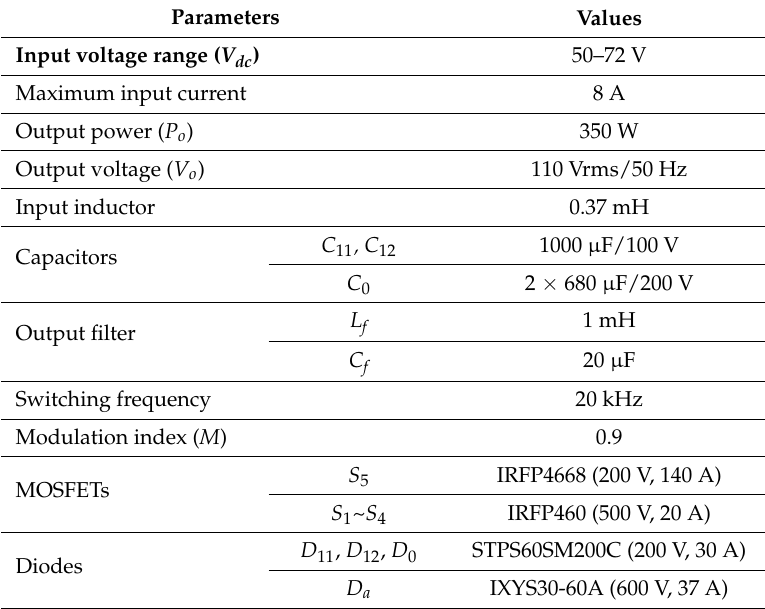
Table 2. Parameters used for simulation and